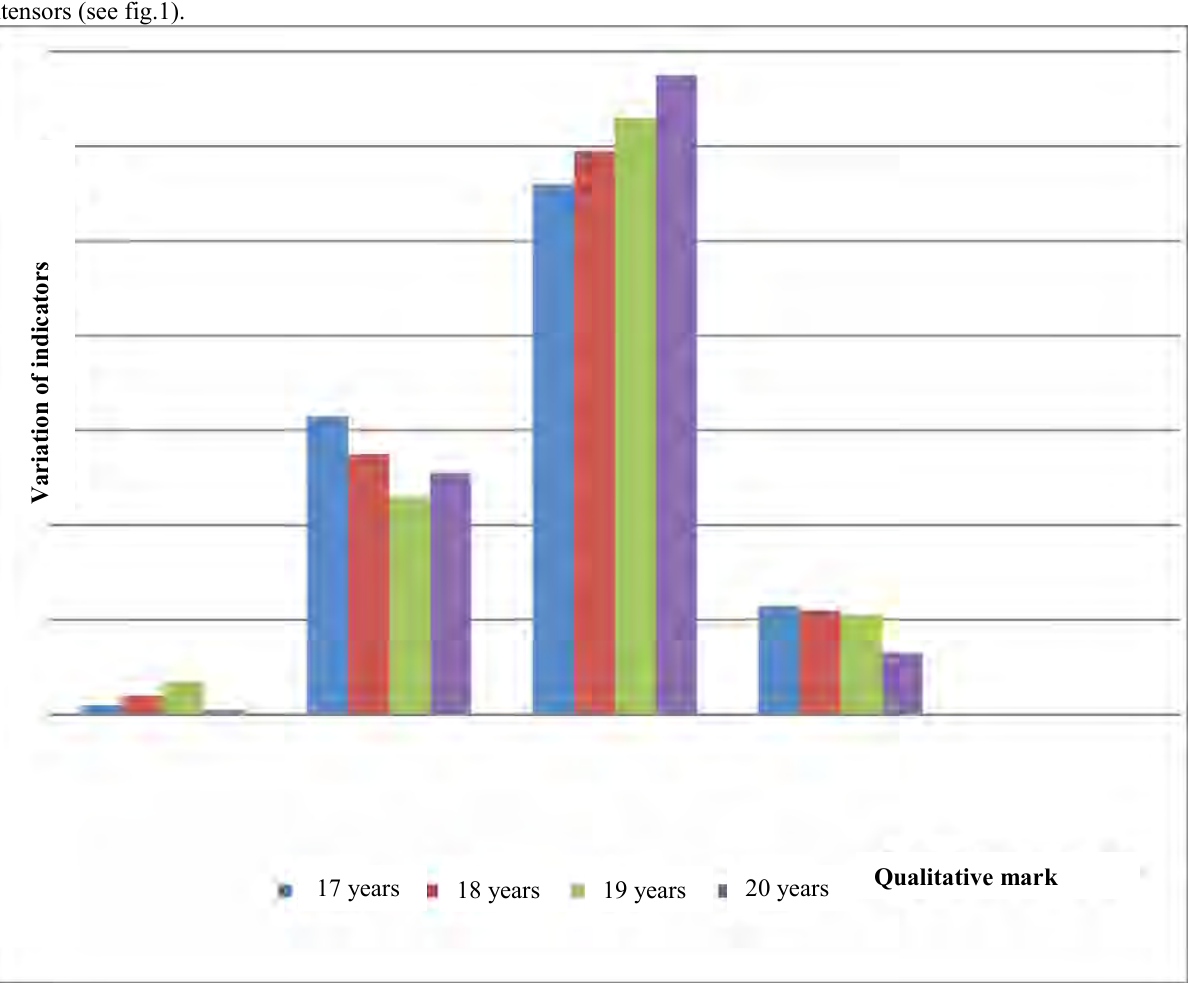
Fig.1. Indicators of complex mark of maximal strength’s development of 17-20 years old girl studentst, calculated